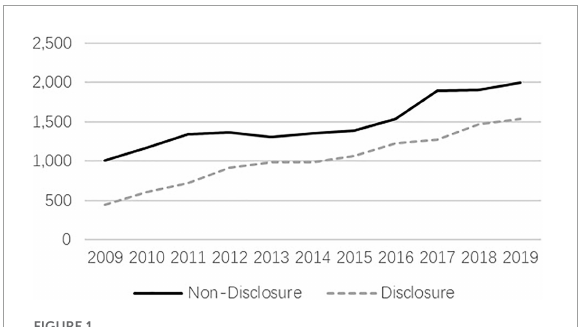
FIGURE1 Number of companies disclosing carbon information versus those not disclosing carbon